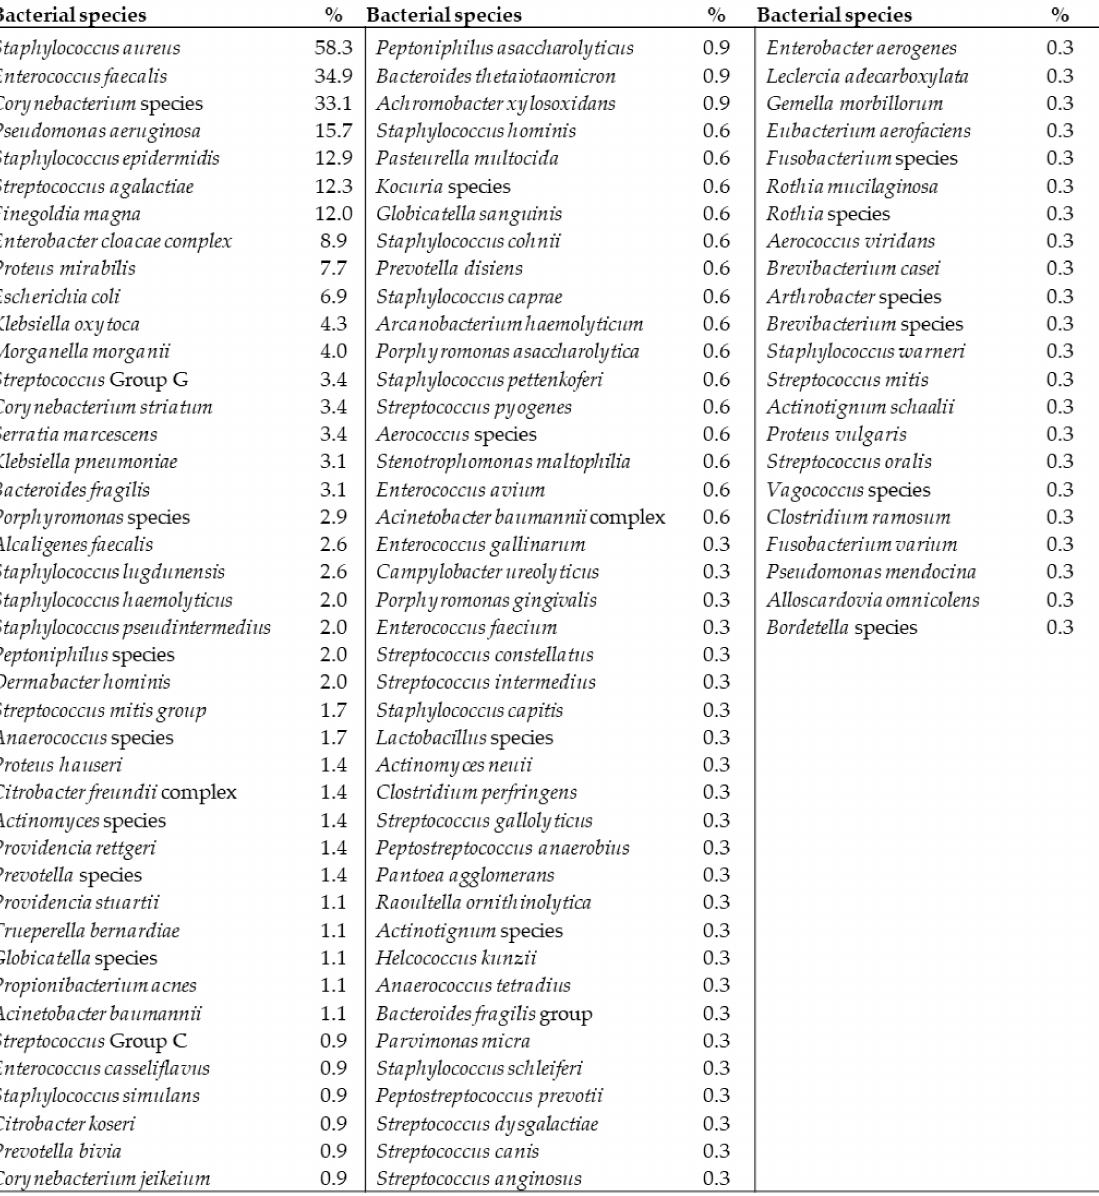
Figure 2. Prevalence of bacterial species detected. Percent denotes frequency of each species detected across the 350 wounds